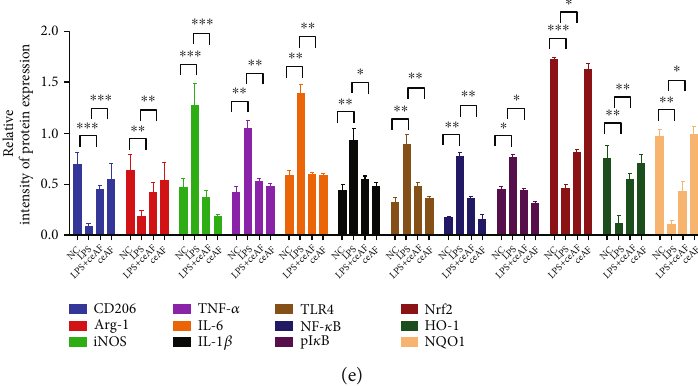
Figure 1: ceAF was able to suppress in fl ammation and oxidative stress via TLR4/NF- κ B and Nrf2 pathways in LPS-stimulated RAW 264.7 cells via TLR4/NF- κ B and Nrf2 pathways. (a) The viability of RAW 264.7 cells exposed to ceAF at various concentrations. (b) The expression levels of CD206, Arg-1, iNOS, IL-1 β , IL-6, and TNF- α were assessed by RT-qPCR. (c) The levels of ROS SOD, GSH-Px, MDA, and MPO were measured. (d) WB results of the in fl uence of ceAF on macrophage markers and TLR4/NF- κ B axis. CD206, Arg-1, iNOS, IL-1 β , IL-6, TLR4, TNF- α , NF- κ B p65, pI κ B Nrf2, HO-1, and NQO1 were tested, and GAPDH served as a standard reference. (e) Bands from the WB in (d) were analyzed by densitometry. n = 3 , Mean ± SEM . NC: negative control; ∗ P < 0 : 05 , ∗∗ P < 0 : 01 , ∗∗∗ P < 0 : 001